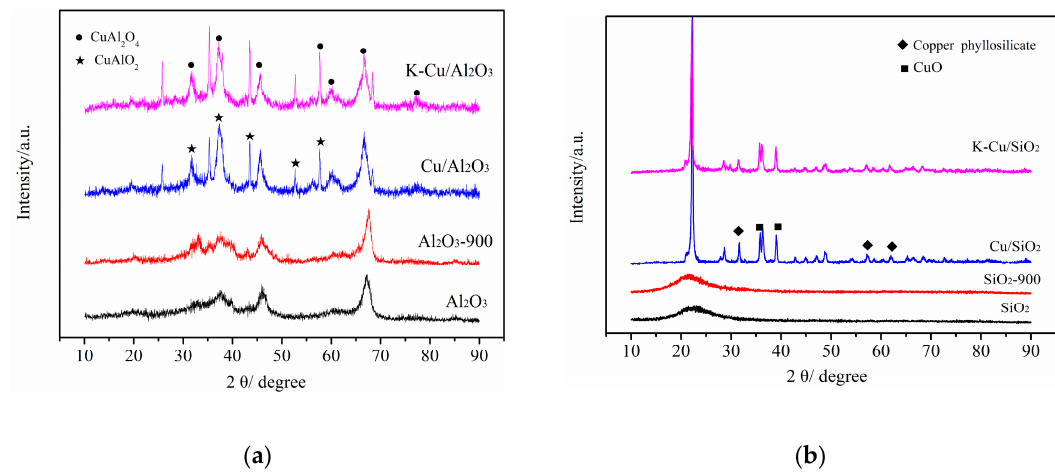
Figure 1. X-ray diffraction (XRD) patterns of ( a ) Al 2 O 3 , Al 2 O 3 -900, Cu/Al 2 O 3 , K-Cu/Al 2 O 3 catalysts and ( b ) SiO 2 , SiO 2 -900, Cu/SiO 2 , K-Cu/SiO 2 catalysts.